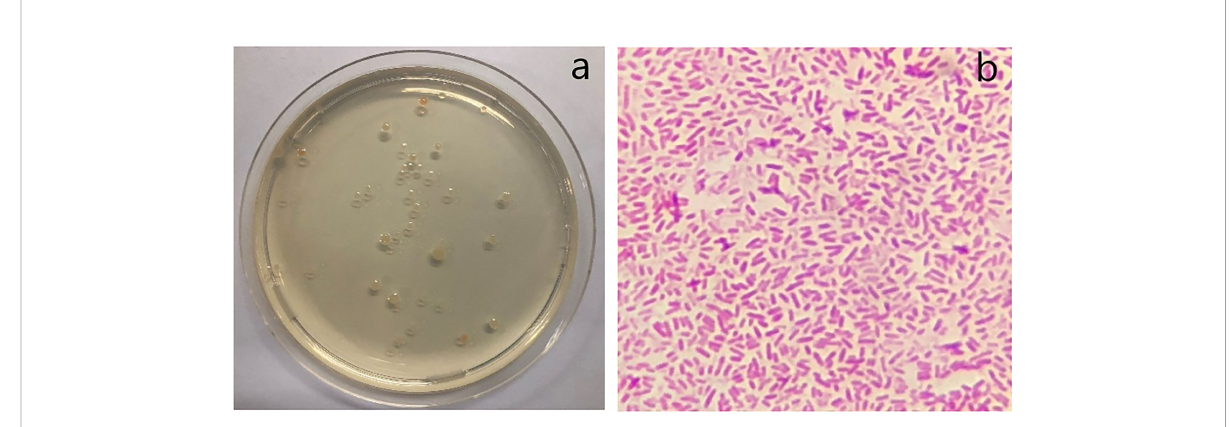
FIGURE 5 Growth of bacteria in the cell culture (A) and gram-negative bacteria observed under an optical microscope (B)